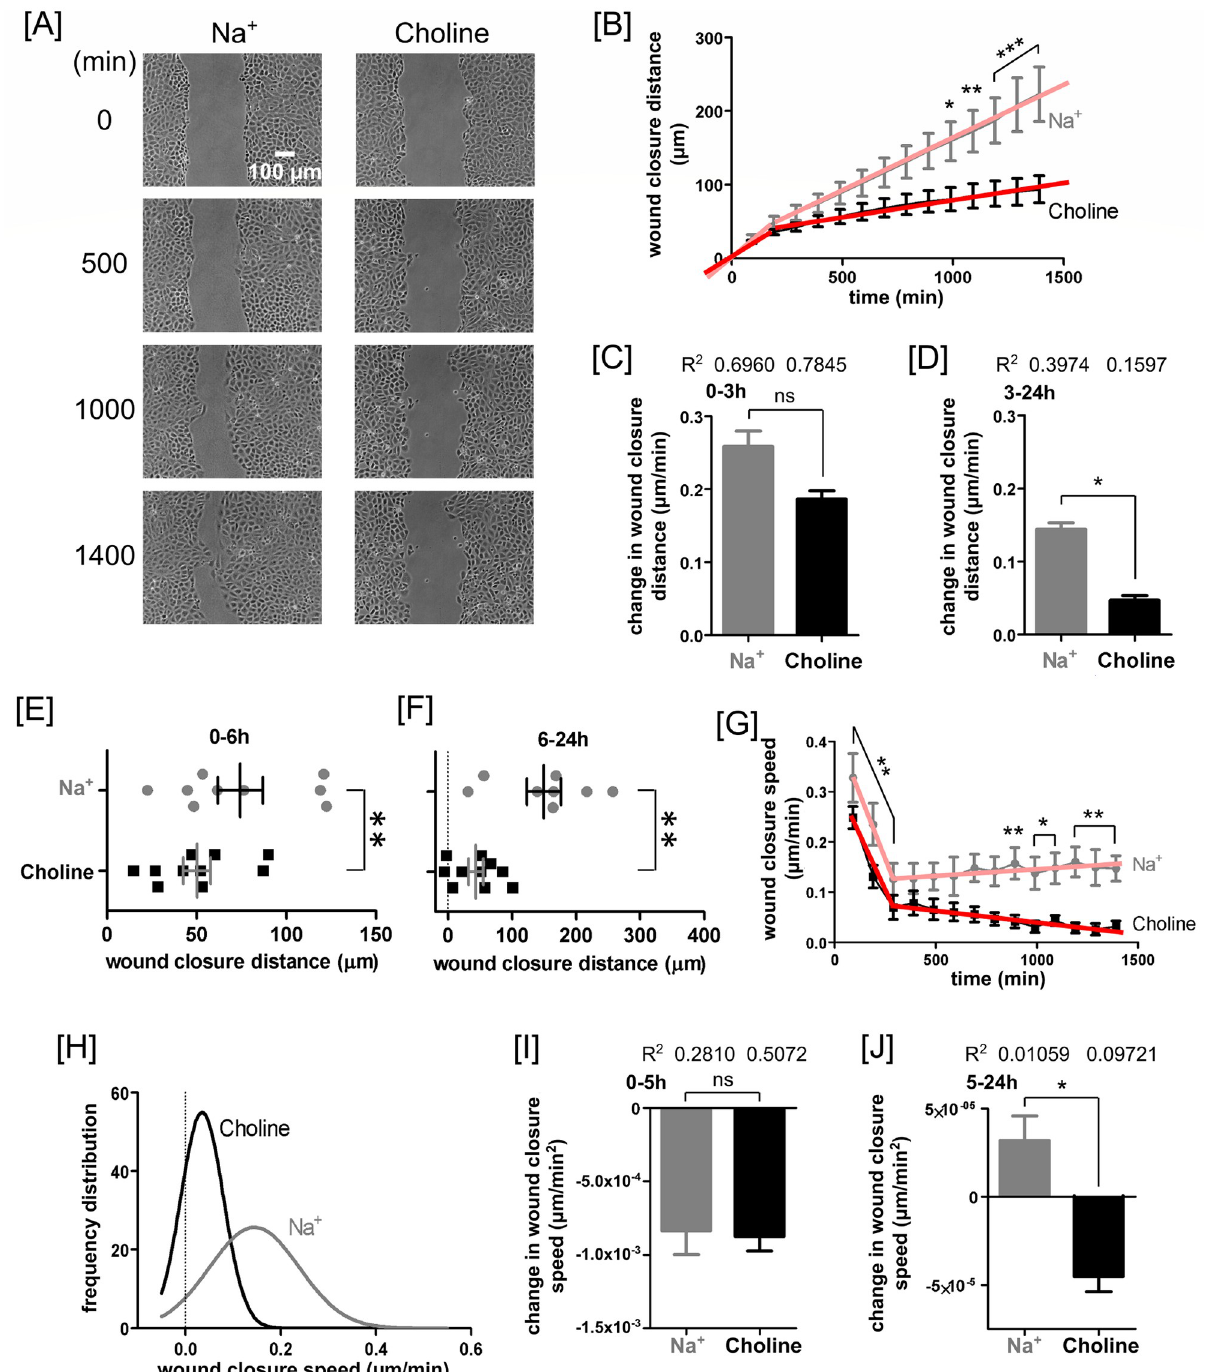
Fig 2. Contribution of extracellular Na + to the 24-hour progression of PAEC wound closure. (A) Sequential phase-contrast images of PAEC monolayers show wound closure in Na + - and choline-containing media. The wound closure was faster in Na + than in choline condition. (B) The plot of wound closure distance as a function of time in a Na + - and choline-containing media. At each time point, wound closure distances were always quantified from time 0. In both conditions, wound closure occurred in two phases. These phases were analyzed using two linear regression fits, one from 0 to 190 minutes and other from 190 to 1390 minutes. The wound closure distance between 990 and 1390 minutes was significantly larger in Na + condition than in choline condition. Bar plot of the slope of (C) the first linear regression fit (time 0 to 190 minutes), and (D) the second linear regression fit (time 190 and 1390 minutes) through the wound closure distances in Na + - and choline-containing media. During both phases, the wound closure distance in choline-containing media trailed that in the Na + -containing media. However, the difference was statistically significant only for the